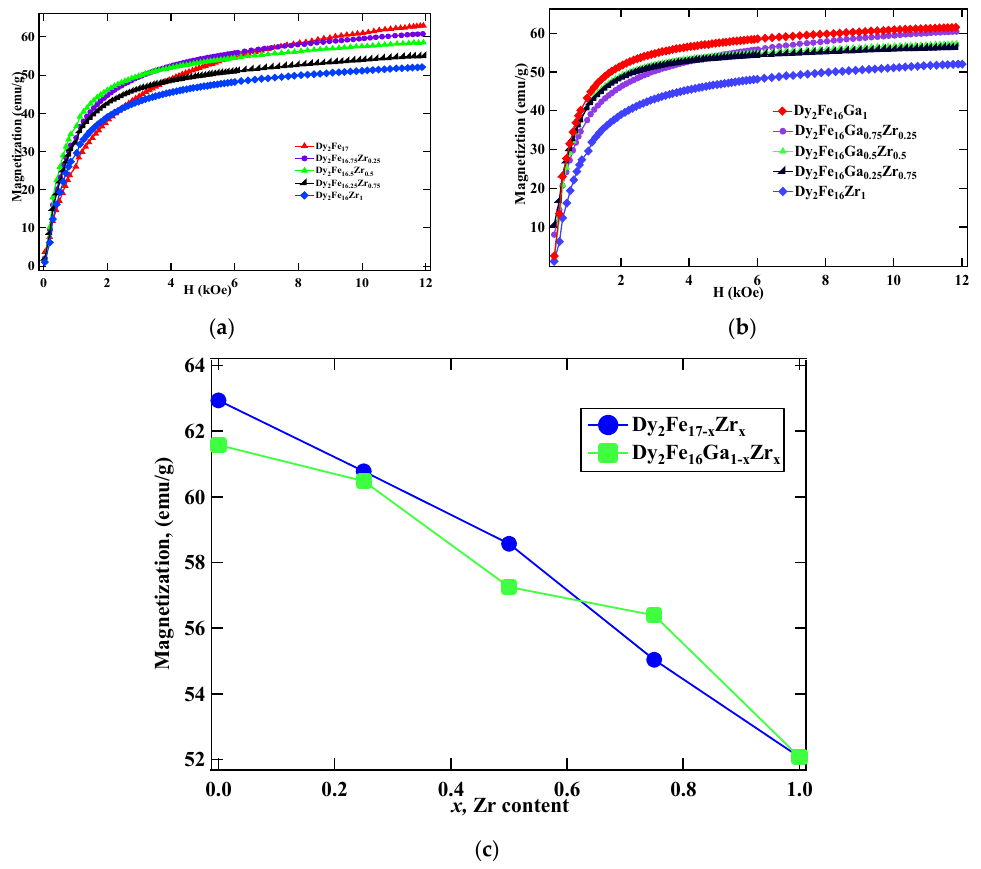
Figure 5. Room temperature (RT) M vs. H plot of ( a ) Dy 2 Fe 17 − x Zr x and ( b ) Dy 2 Fe 16 Ga 1 − x Zr x ; ( c ) magnetization (Ms) vs. x for Dy 2 Fe 17 − x Zr x and Dy 2 Fe 16 Ga 1 − x Zr x . The Curie temperature (Tc) of Dy 2 Fe 17 − x Zr x and Dy 2 Fe 16 Ga 1 − x Zr x as a function of Zr content